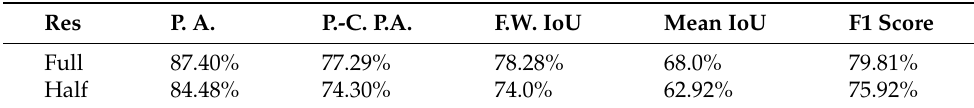
Table 3. Prediction accuracy of the trained Fast-SCNN on the custom version of COCO-Stuff at full and half resolution. P.A. stands for Pixel Accuracy, P.-C. for Per-Class and F.W. for Frequency- Weighted. The results are presented with images at full and half